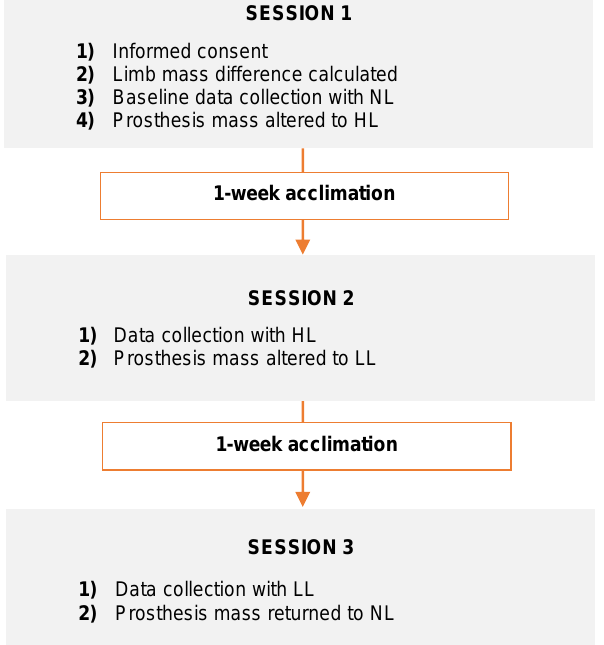
Figure 1: Timeline of research sessions for one participant. The order of HL or LL was counterbalanced so that half received HL at session 1 then LL at session 2 and half received LL at session 1 then HL at session 2. NL= No load, LL= Light load, HL= Heavy